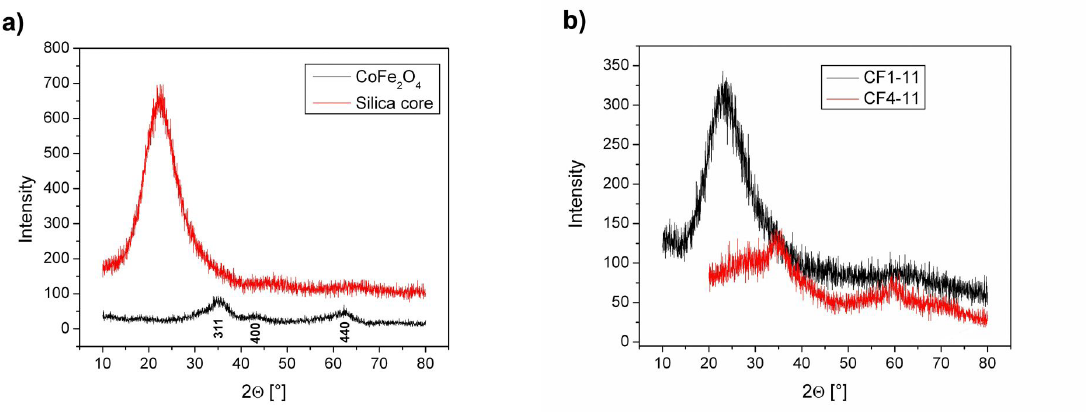
O ); b) monolayered (CF -11) and four- 2 4 1